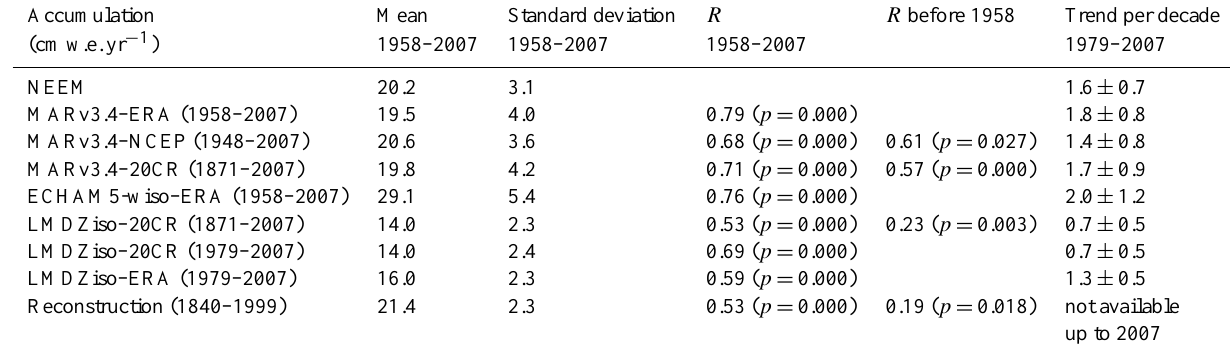
Table 3. Comparison of NEEM δ 18 O with simulations. δ 18 O‰ Mean Standard R Trend per decade deviation